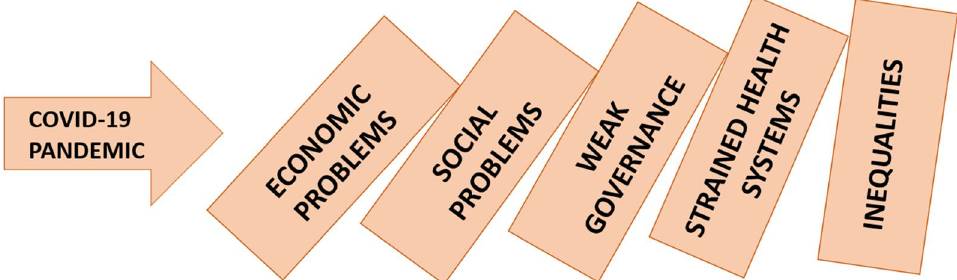
Fig. 1 The domino effect of the COVID-19